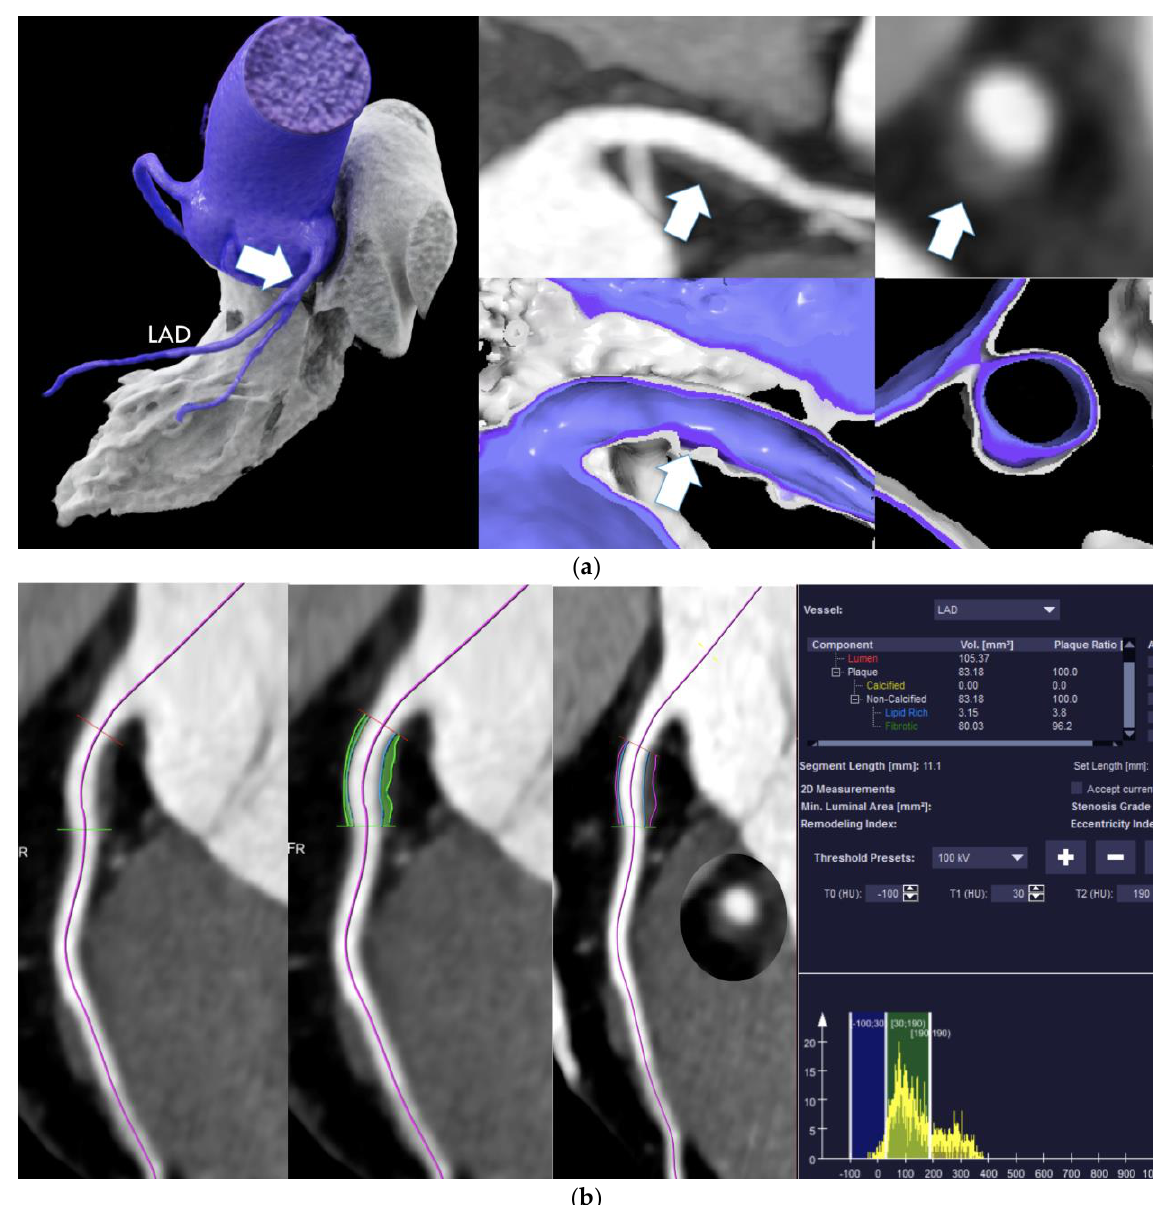
Figure 1. ( a ) A 30 year-old-male with diabetes since 14 years, presenting with ketoacidosis to our ED. Hs-Troponin (49 ng/dL) and HBA1c (11.2%) were elevated. CTA (A) showed a non-calcified lesion (white arrows) in the proximal LAD with positive remodeling (“high-risk- plaque”—HRP) with quantitative 3.15 mm 3 lipid-rich necrotic core plaque volume (LAP < 30 HU) ( b ) based on CTA. CACS was 0. There was no calcific plaque components by CTA ( a ). Manual contour editing ( b ) was performed if automated tracing of lesion borders was inaccurate (mid cMPR and right cMPR) (SyngoVIA TM Frontier Research, Siemens Healthineers): VRT (left) and MPR (mid and right). ( b ) cMPR and quantitative plaque analysis.